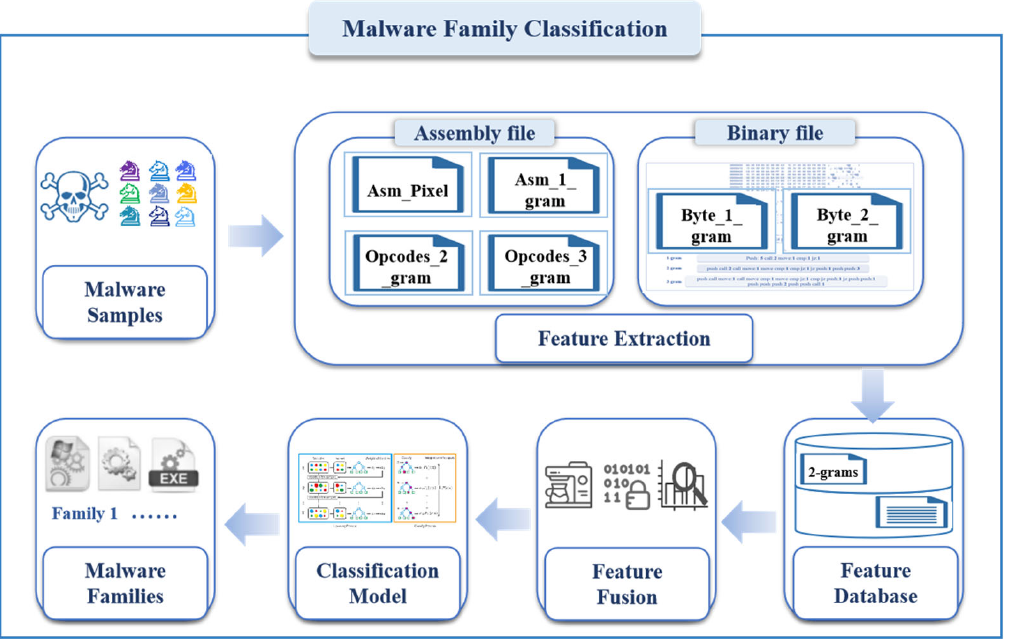
Figure 3. Overview of our proposed architecture.